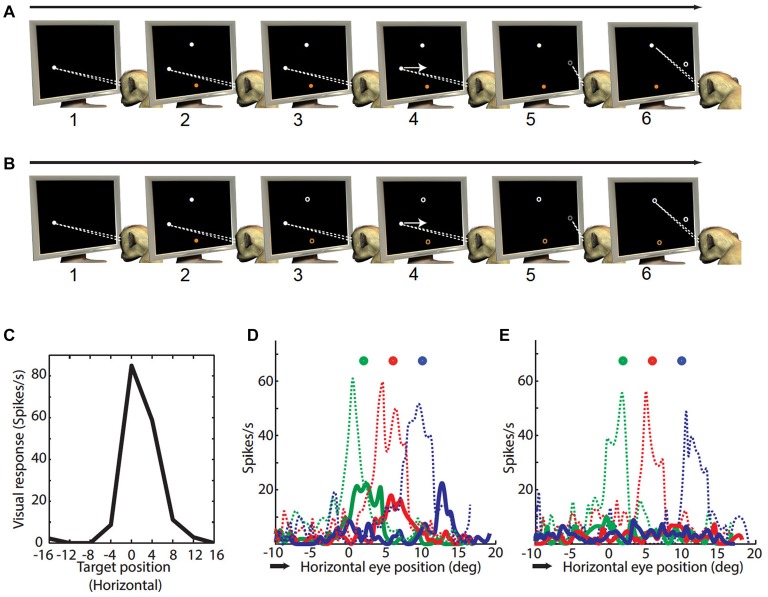
Paradigms. (A) Smooth pursuit (SP) visual task: (1) monkey fixated a white dot on the CRT monitor; (2–3) while fixating a peripheral target (white) and distracter (orange) appeared and continued to be visible; (4) the fixation dot started to move with a constant velocity (10°/s). Monkey followed the white dot with SP. The paradigm was configured in such a way that the target or distracter (white or orange dot) corresponded to the visual receptive fields (RF) of the neuron somewhere during the SP; (5) at an unpredictable time during SP the white SP target disappeared; (6) at this point the animal was required to make a saccade towards the visual target (white peripheral dot). (B) SP updating task: (1) monkey fixated a white dot on the CRT monitor; (2) while fixating a peripheral target (white) and distracter (orange) appeared for 200 ms and disappeared; (3) the animal kept the location of target in memory (memory target) and continued looking at fixation dot for another 300–500 ms; (4) the fixation dot started to move with a constant velocity (10°/s). Monkey followed the white dot with SP. The paradigm was configured in such a way that the memory target corresponded to the visual RF of the neuron somewhere during the SP; (5) at an unpredictable time during SP the white dot disappeared; (6) at this point the animal was required to make a saccade towards the memory target. The paradigm required the animals to continuously update its location during the SP. (C) One dimensional visual RF parallel to SP direction: the panel gives the average firing rate for visual stimulation (black) for various targets during memory saccade paradigm. The choice of these targets depended on the configuration of subsequent SP-visual/updating task. The targets corresponds to nine locations spanning from −16 to 16° in horizontal axis with a fixed vertical component of 5°. This visual neuron was most active at 0°/5° (horizontal/vertical), and was also active at 4°/5°. (D) Visual and updating responses to target: shows the neural activity in screen coordinates during SP visual/updating task (neural activity as a function of horizontal eye position). This is an example of updating across horizontal SP (from 10° leftward towards 18° rightwards; black arrow indicates SP direction) followed by a saccade to different visual/memory target (circles; targets were not visible during SP in SP updating task but visible during SP visual task). Colors indicate sets of trials associated with different visual/memory targets. (E) Visual and updating responses to distracter: same as (D) except visual and updating responses were collected when distracter corresponded with the RF of the neuron.